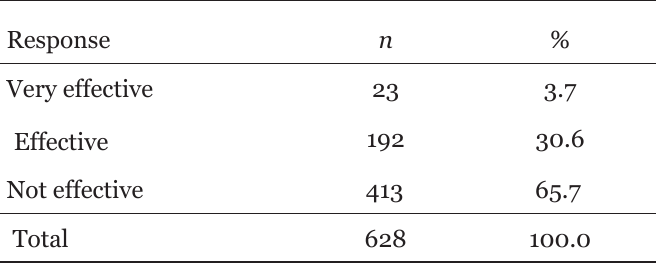
Students Response on the Use of Resource Centres